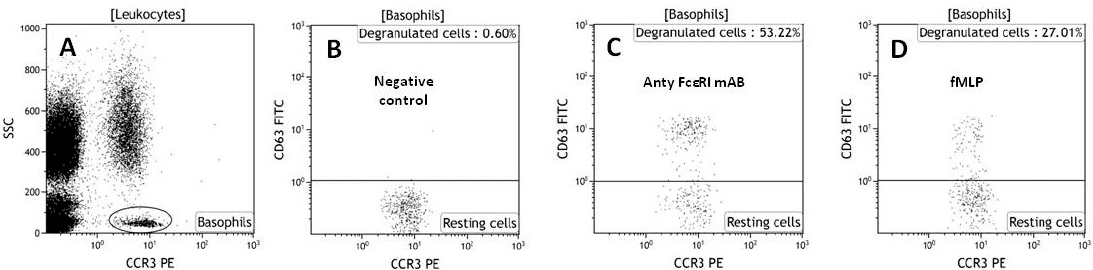
Figure 2. Representative dot plots (based on our own data) showing gating strategy of basophils based on low SSC-A values and high CCR-3 expression ( A ); Basophils were displayed in a graph with CCR3-PE on the x-axis and CD63 FITC on the y-axis; negative control ( B ); cells activated with stimulating antibodies ( C ); cells stimulated by bacterial tripeptide-fMLP ( D ).